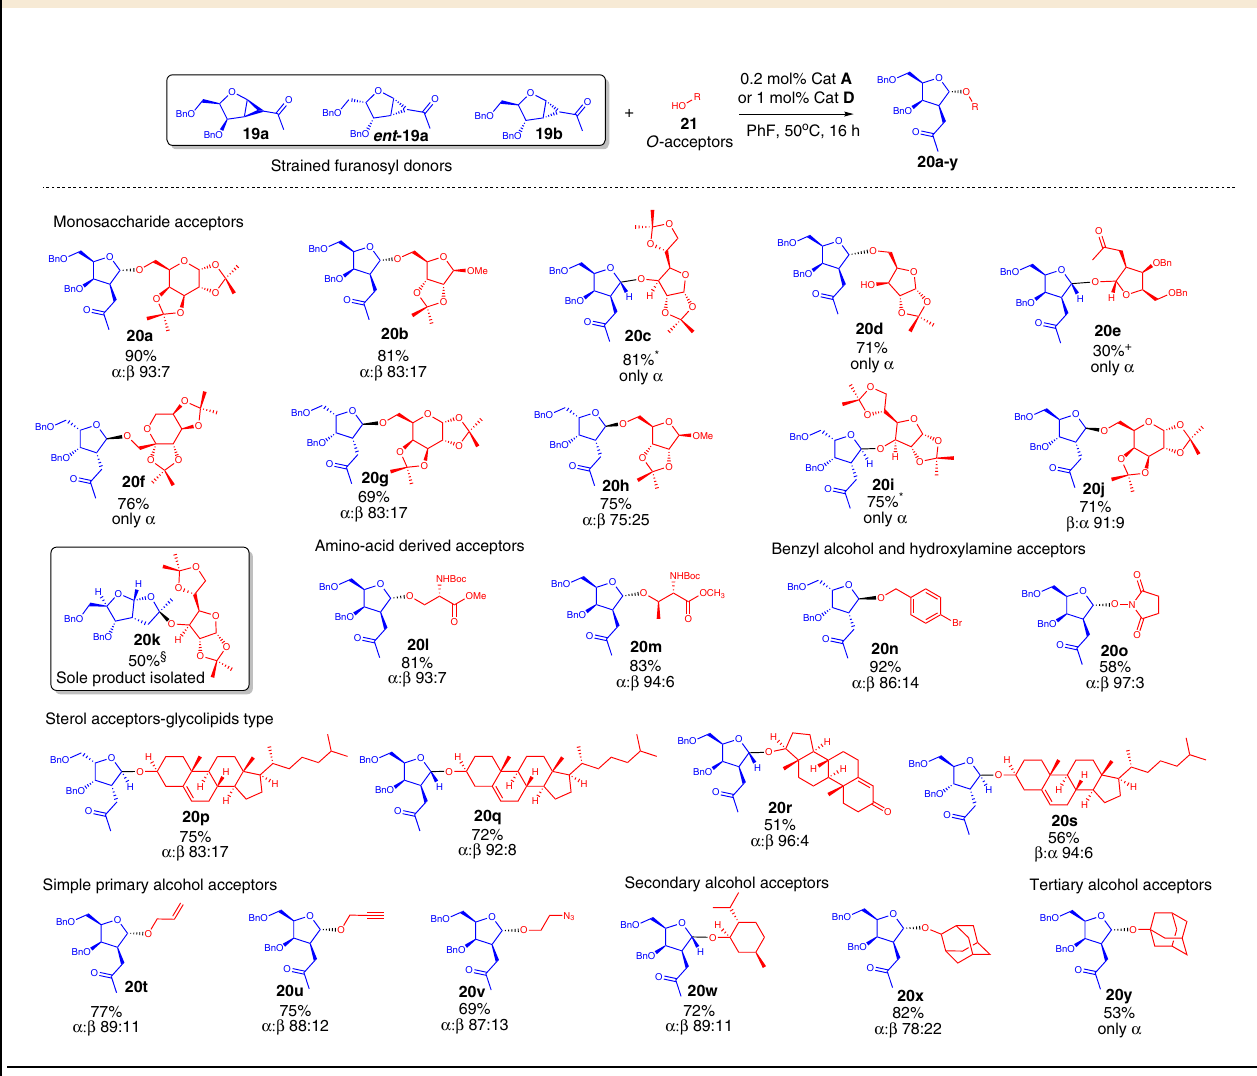
Table 2 O -Furanosylation substrate scope using sub-molar catalyst loadings